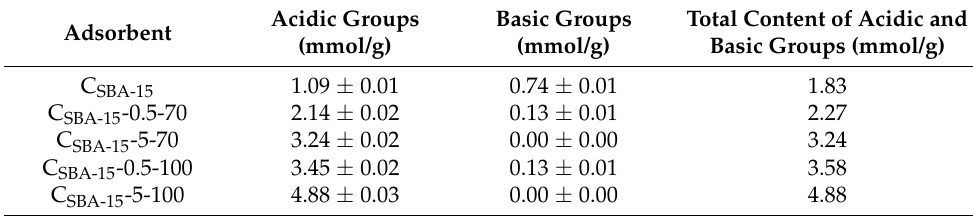
Table 2. The results obtained from Boehm titration. Acidic Adsorbent